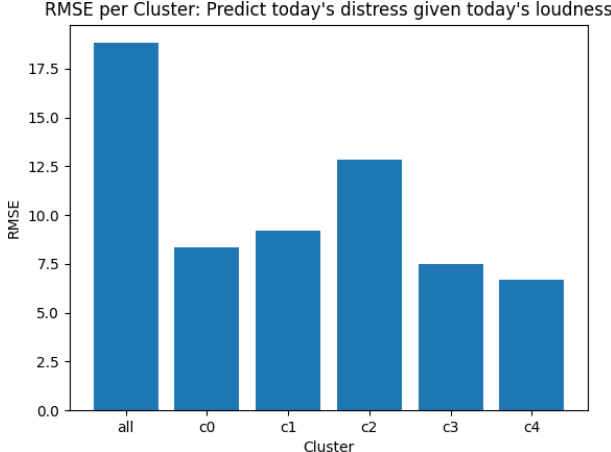
Figure 5. Out-of-sample prediction errors: Comparing the cluster-model errors against a model trained on all